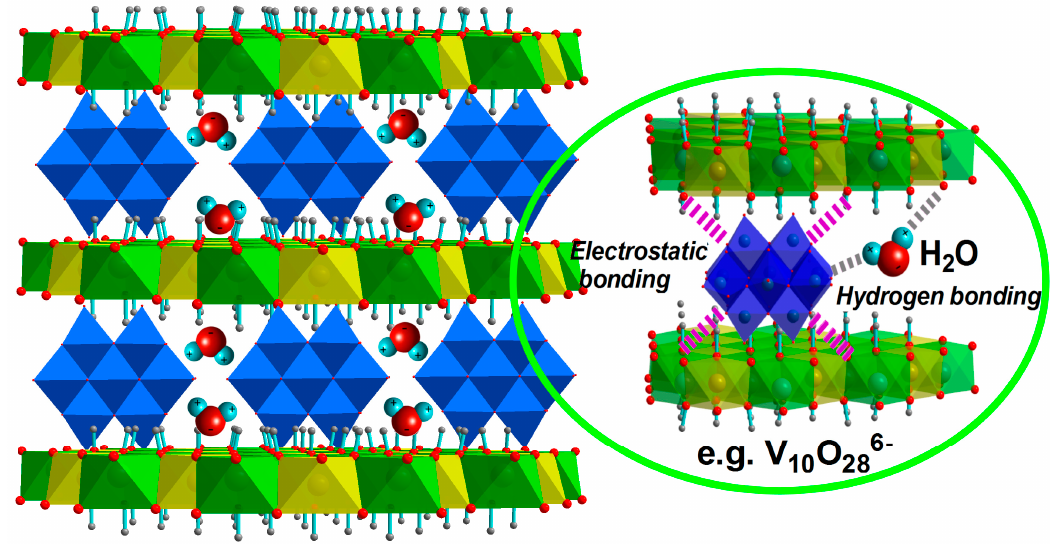
Figure 2. Schematic representation of POM-LDHs structure (e.g., V 10 O 286 − intercalated in ZnAl-LDH). Adapted from Ref. [12], Copyright 2014, Elsevier.